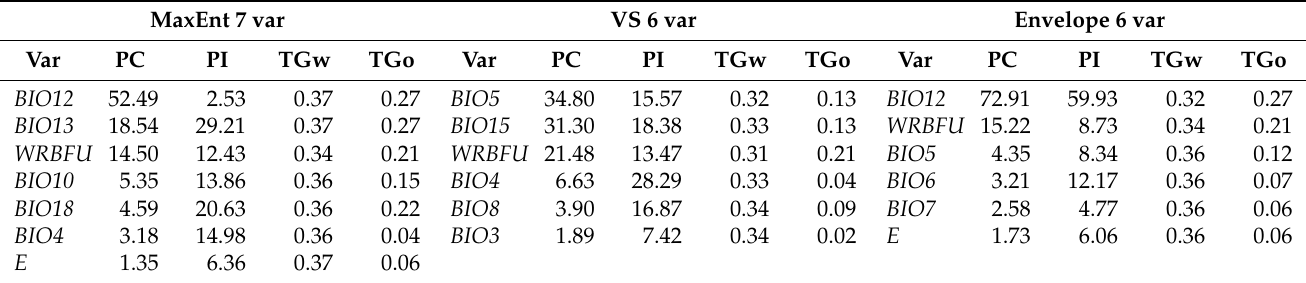
Table 6. Variables contribution for each variable set